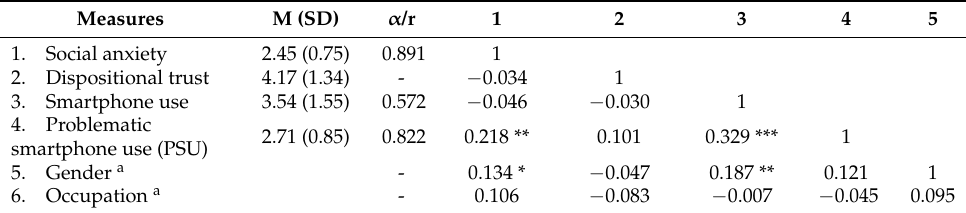
Table 1. Means, standard deviations, internal consistency measures and bivariate correlations ( n =